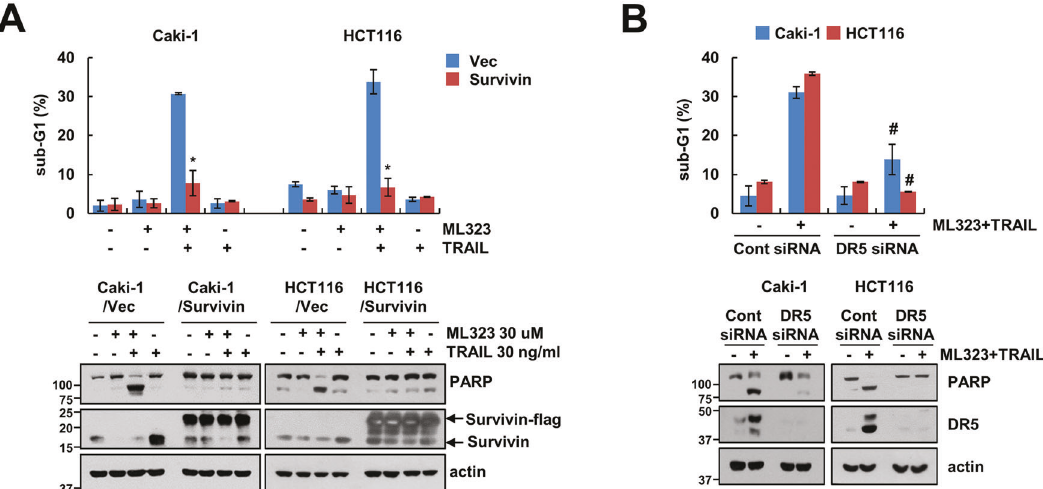
Fig. 6 Downregulation of survivin and upregulation of DR5 contribute to ML323-mediated TRAIL sensitization. Caki-1 and HCT116 cells were transfected with vector and fl ag-survivin ( A ) or control siRNA or DR5 siRNA ( B ) followed by 30 μ M ML323, 50 ng/mL TRAIL, or combination for 24 h. The sub-G1 population and protein expression were determined using fl ow cytometry and western blotting, respectively ( A, B ). Values in the graphs ( A , B ) represent the mean ± SD of three independent experiments. * P < 0.01 compared to combination of ML323 and TRAIL in vector. # P < 0.01 compared to combination of ML323 and TRAIL-treated control siRNA-transfected group.